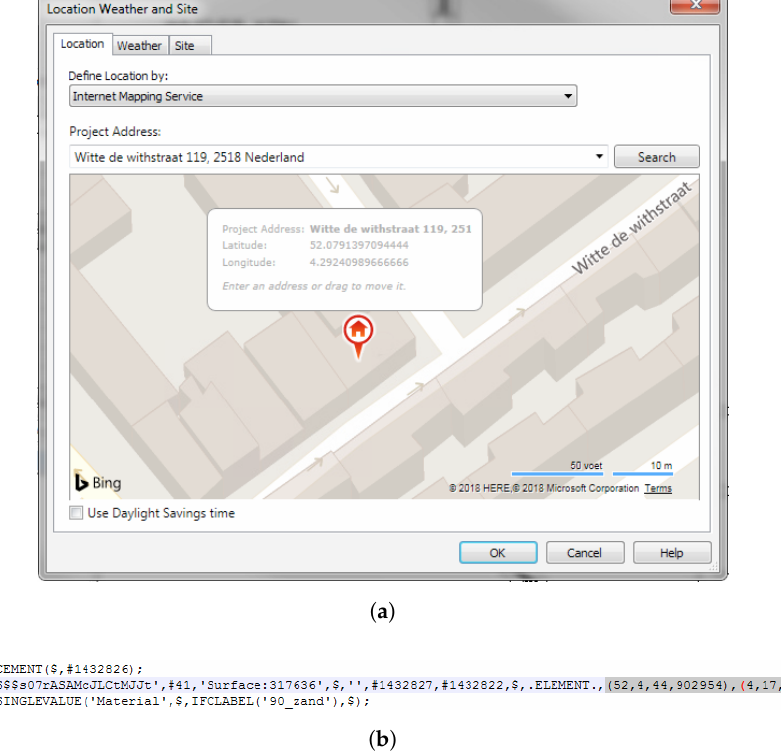
Figure 16. Correcting the location of the Witte de Withstraat model. ( a ) Setting in correct location in the Internet Mapping Service tool; ( b ) The new coordinates in the IFC